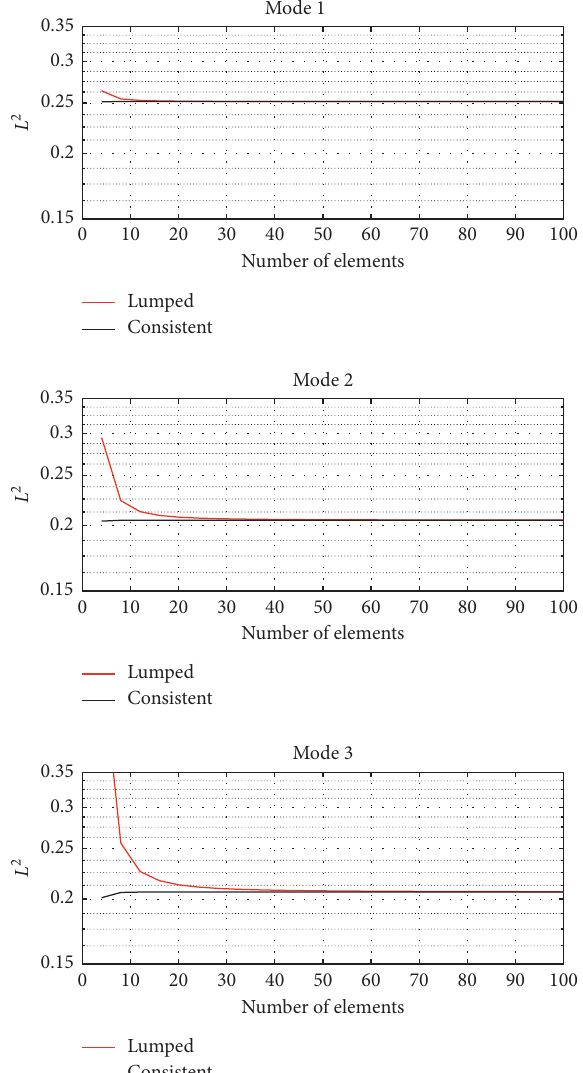
Figure 7: Convergence of the length of the mode shapes for the first three modes of the cantilever beam with nonconstant mass